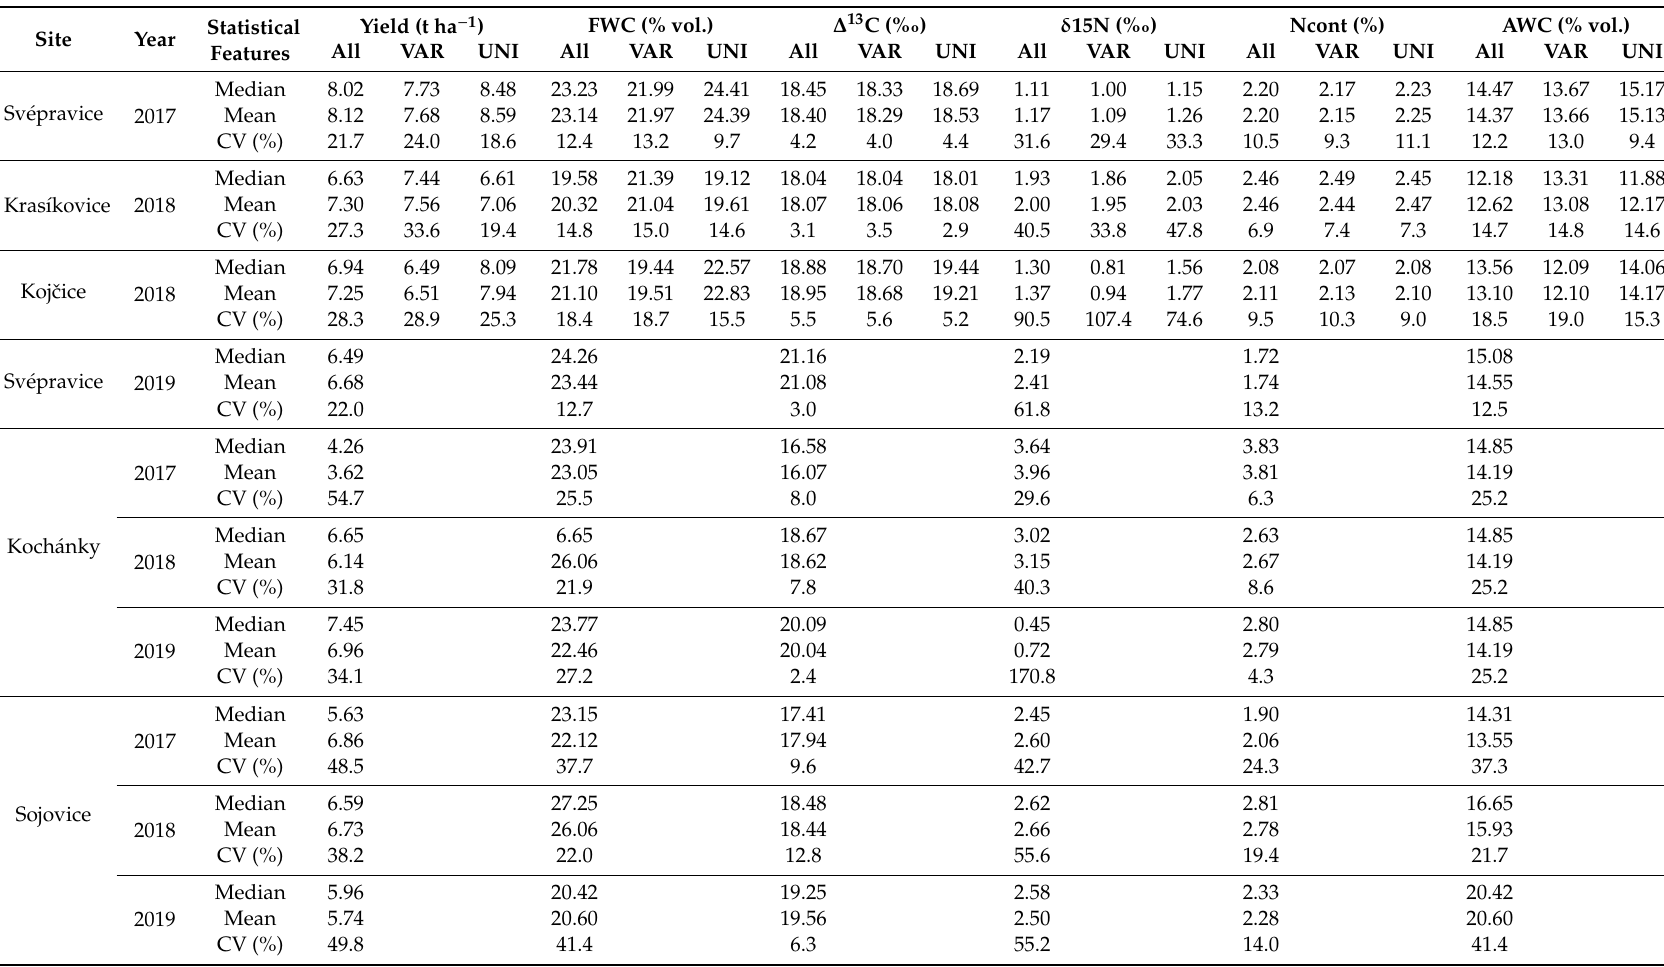
Table 1. Median, mean, and coe ffi cient of variation (CV, %) of the grain yield, the nitrogen (N) content (Ncont) of seeds, 13 C ( ∆ 13 C) and 15 N ( δ 15 N) discrimination, and field (FWC) or available (AWC) water capacity. VAR, fertilized variably; UNI, fertilized uniformly. Statistical Site Year